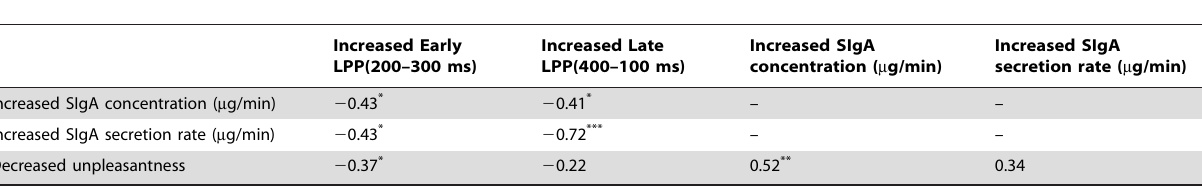
Table 1. Correlations among the changes in SIgA, ERPs and emotional